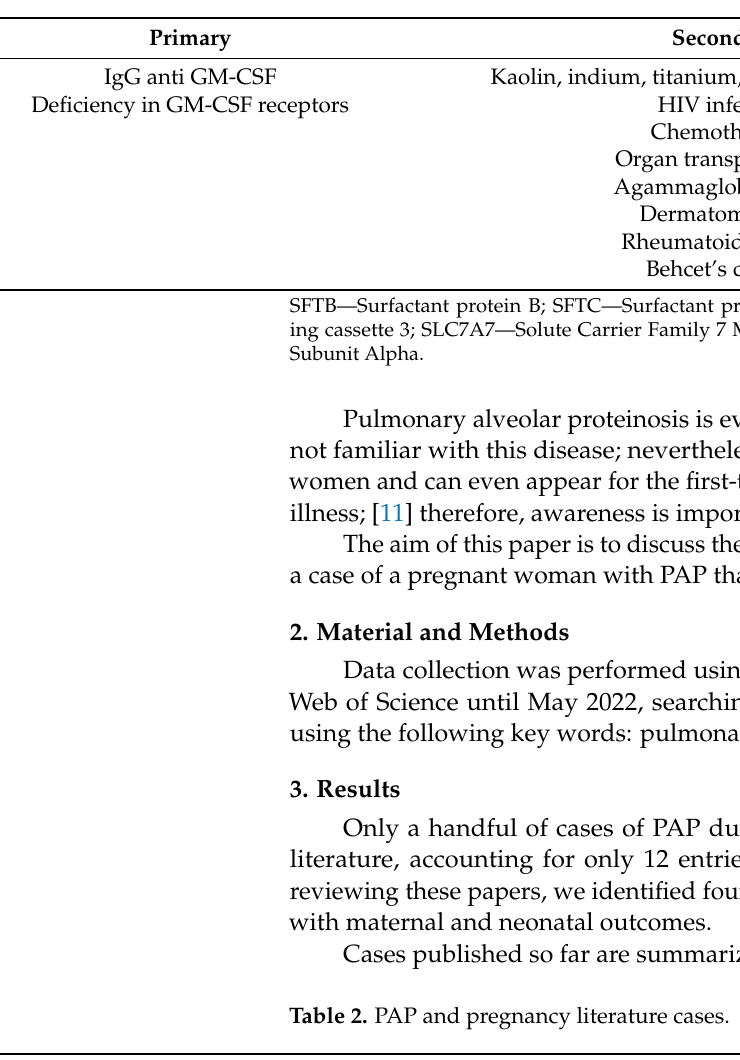
Table 1. Causes of